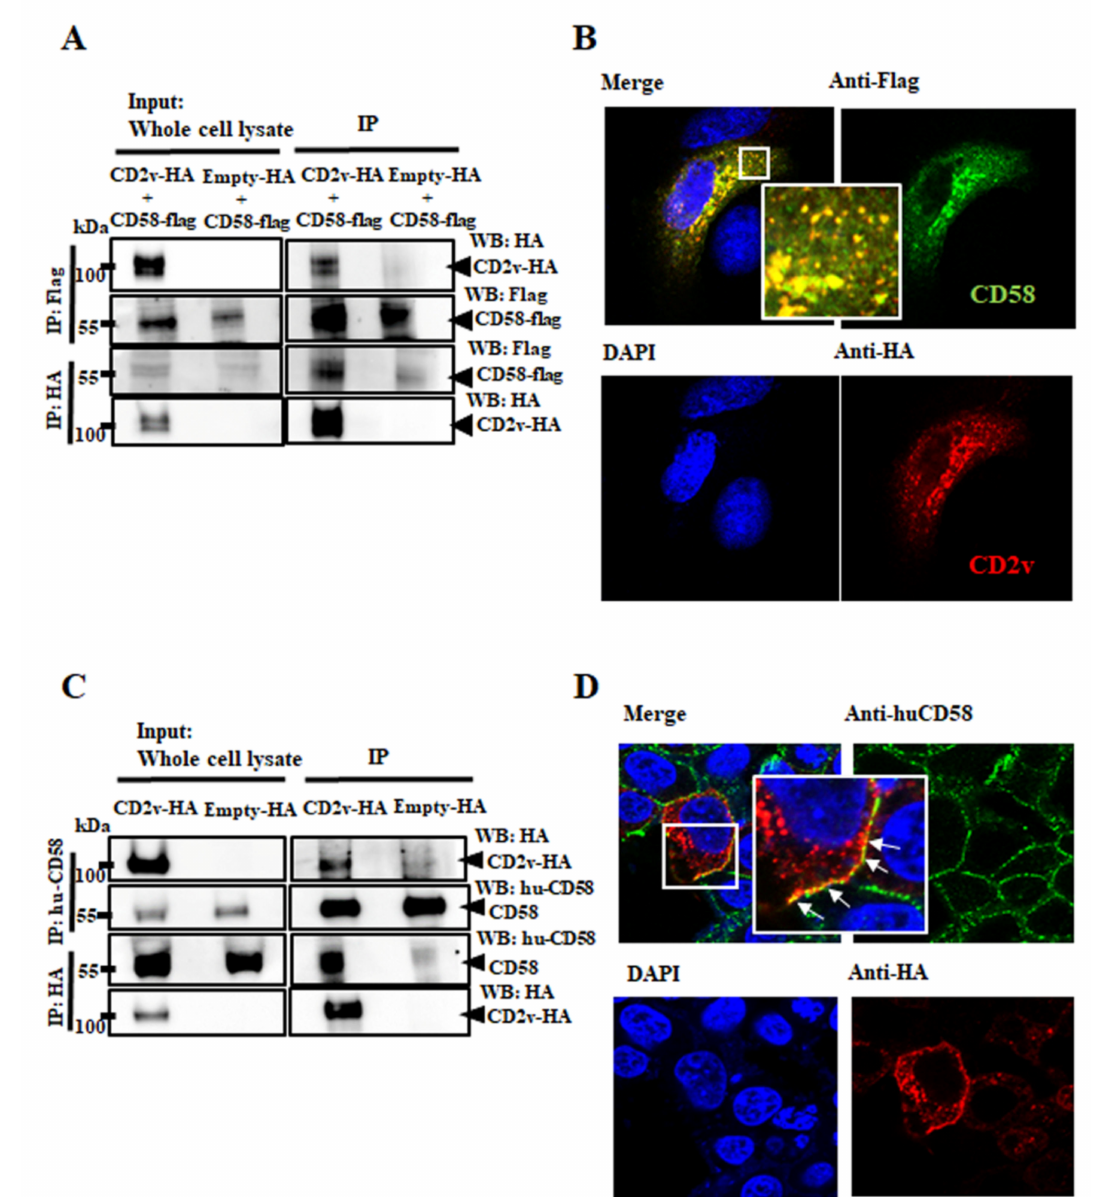
Figure 4. Interaction between CD2v and CD58. (A,B) Interaction between CD2v and porcine CD58. ( A ) PK15 cells were cotransfected with plasmids pCD58-Flag and pCD2v-HA or pCD58-Flag and pEmpty-HA (control) and harvested at 8 h pt. Whole cell lysates (left) and extracts immunoprecipitated with anti-Flag antibodies or anti-HA were examined by Western blotting with antibodies directed against proteins indicated on the right. ( B ) PK15 cells were cotransfected with pCD58-Flag and pCD2v-HA, fixed at 24 h pt, incubated with mouse anti-Flag and rabbit anti-HA primary antibodies, washed and incubated with secondary antibodies (Alexa-fluor 488-labeled anti-mouse and Alexa-fluor 594-labeled anti-rabbit). Cells were counterstained with DAPI and examined with the confocal microscope. Insets show magnified areas of the field. ( C ) 293T cells were transfected with pCD2v-HA or pEmpty-HA (control) and harvested at 8 h pt. Whole cell lysates (left) and extracts immunoprecipitated with mouse anti-huCD58 antibodies or anti-HA were examined by Western blotting with antibodies directed against proteins indicated on the right. ( D ) 293T cells were transfected with pCD2v-HA, fixed at 24 h pt, incubated with mouse anti-huCD58 and rabbit anti-HA primary antibodies, washed and incubated with Alexa-fluor 488-labeled anti-mouse and Alexa-fluor 594-labeled anti-rabbit secondary antibodies. Cells were counter stained with DAPI and examined with the confocal microscope. Insets show magnified areas of the field. Results for ( A – D ) are representative of three independent